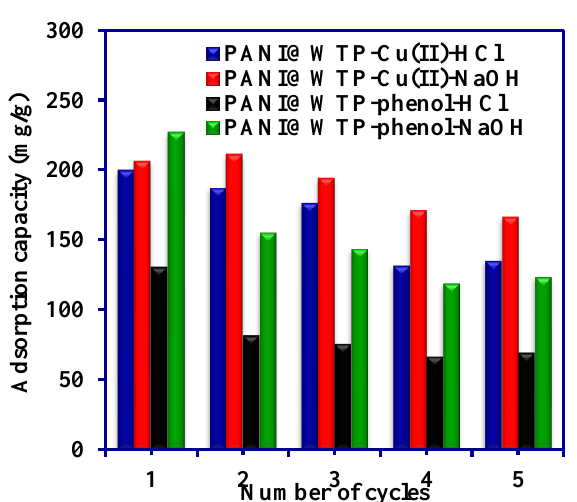
Figure 8. Regeneration of PANI@WTP nanocomposite (concentration, 500 mg/L; volume, 20 mL; adsorbent mass, 0.02 g; pH 5 for phenol, 5.2 for Cu(II); temp, 30 °C).